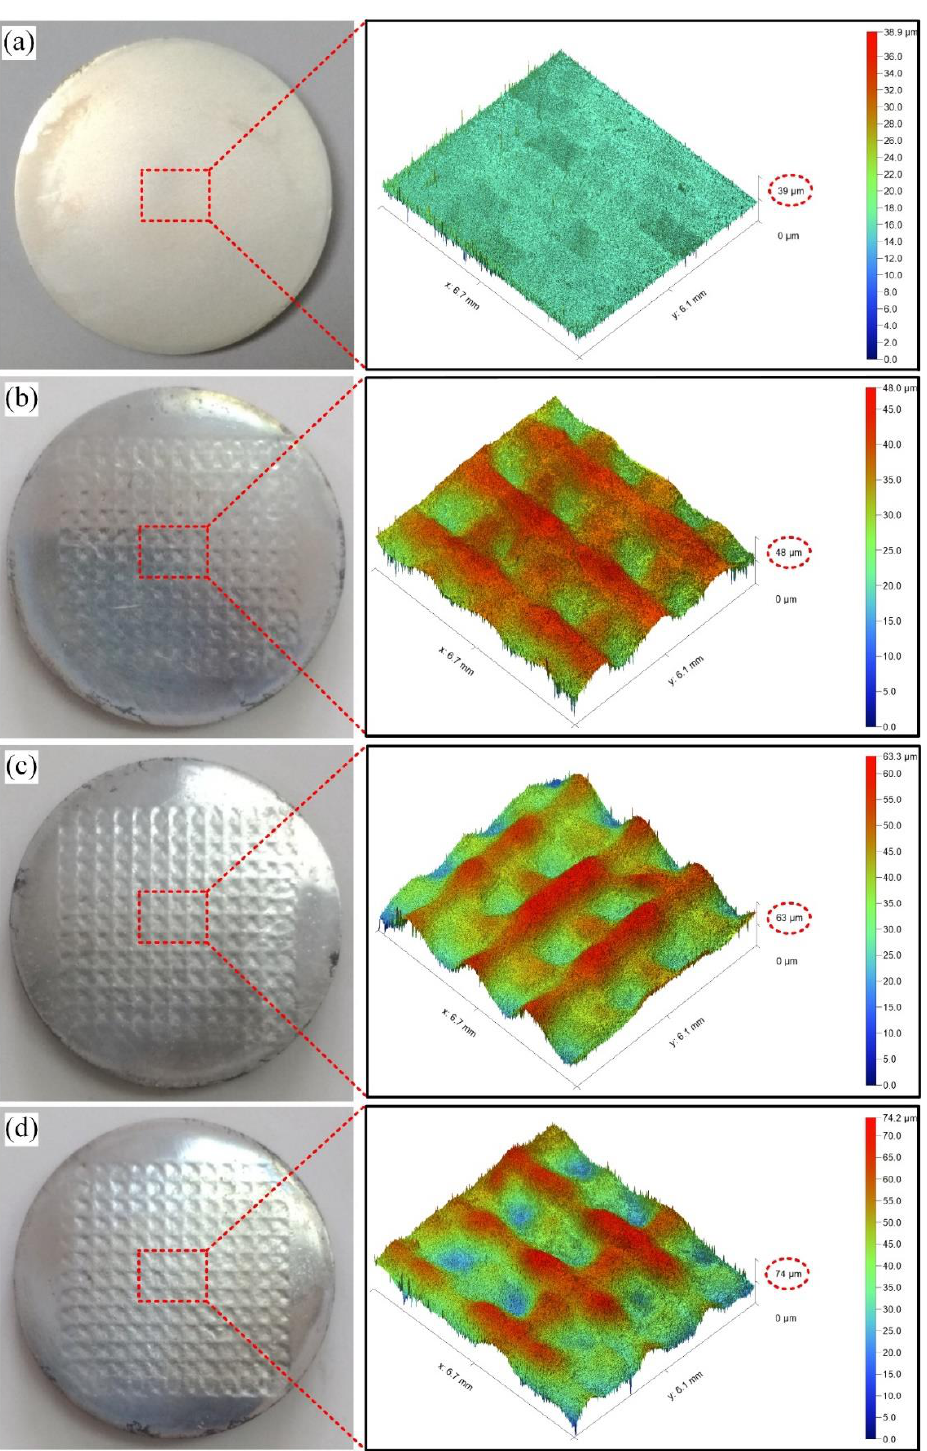
Figure 3. Macroscopic featurse and 3D morphology of surface: ( a ) untreated; ( b ) 1.19 GW / cm 2 ; ( c ) 1.99 GW / cm 2 ; ( d ) 2.79 GW / cm 2